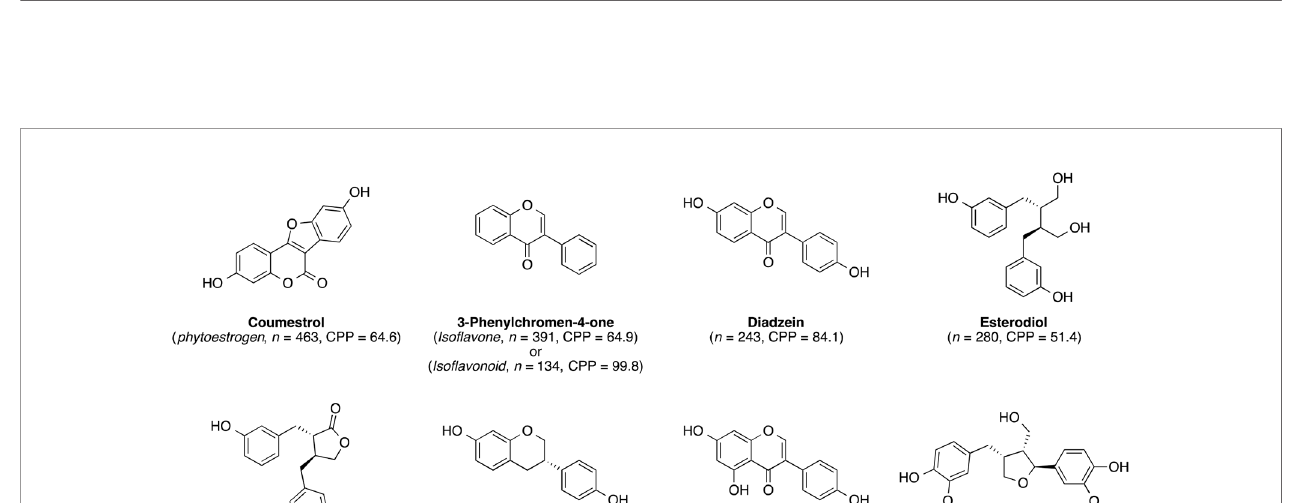
FIGURE 1 | Bubble map visualizing words from titles and abstracts of the 10,742 lignan publications. VOSviewer software was used to evaluate the recurring terms. Only the 311 terms that appeared in at least 1% (n = 108) of the publications were analyzed and visualized. The size of a bubble represents the frequency of appearance of a term (multiple appearances within one publication were treated as one appearance). Two bubbles are positioned more closely to each other if the terms co-appeared more often. The color represents the averaged citations per publication.